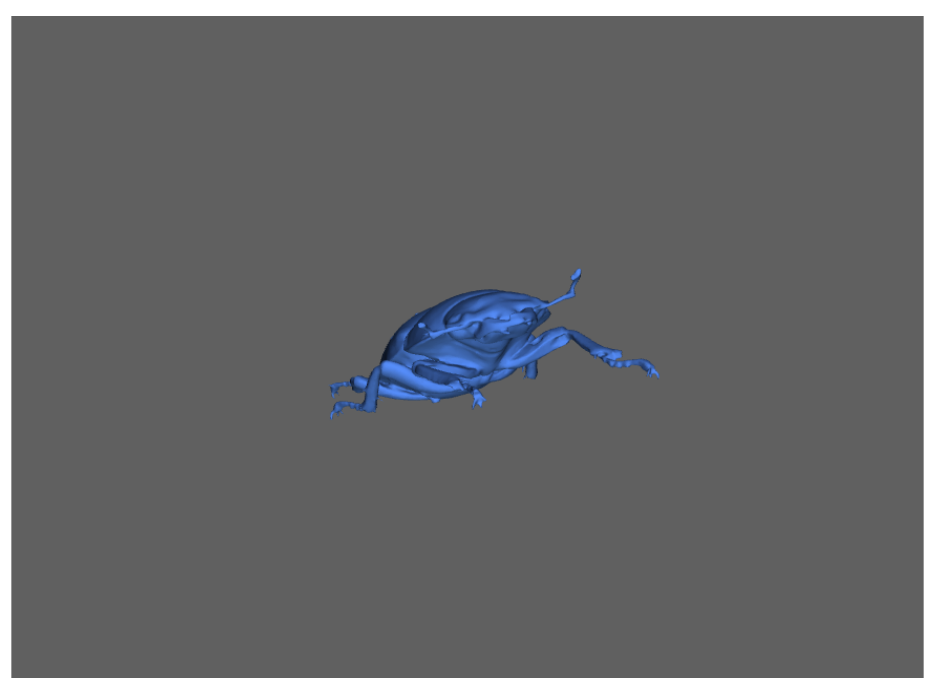
Figure 15. Interactive 3D-model of Prosopocoilus savagei (23 mm body